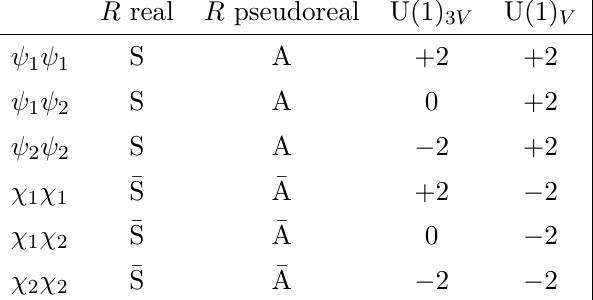
in table 2. The lightest dark particles charged under U(1) stable. In Type I theories with complex R , these are two dark pions (with charge ± 2